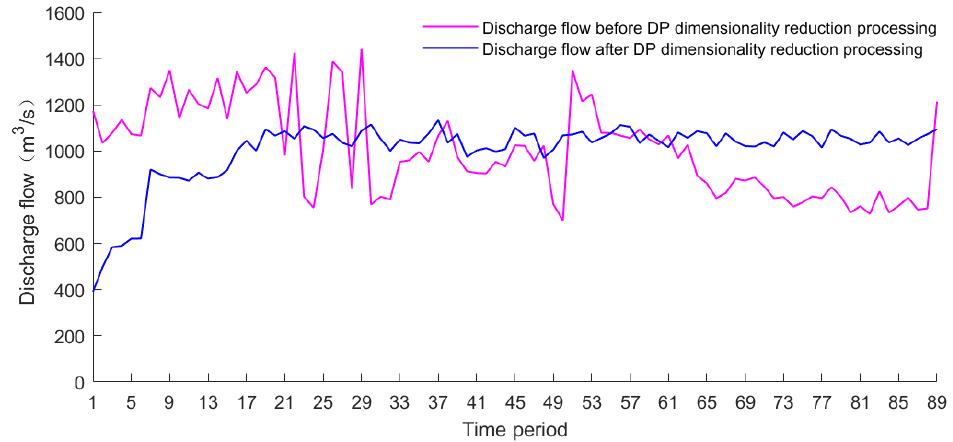
Figure 16. Comparison of discharge flow before and after DP dimensionality reduction processing in the second flood.